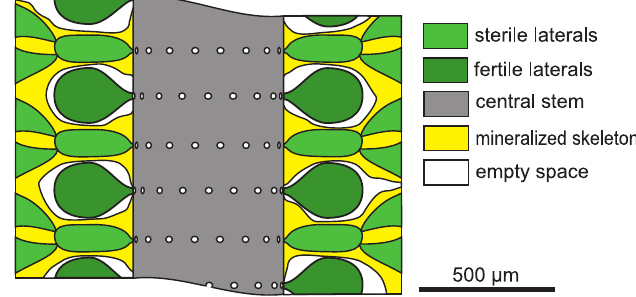
Fig. 2. Structure of dasycladalean alga Chinianella ellenbergeri (Lebou- ché and Lemoine in Granier and Deloffre, 1994) according Lebouché and Lemoine